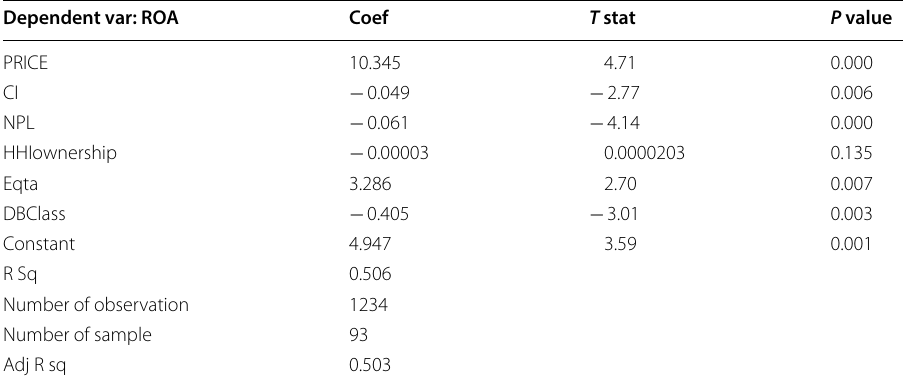
Table 5 Regression result for price—profitability relation. Source: Author’s calculation on data provided by the Indonesia Financial Services Authority